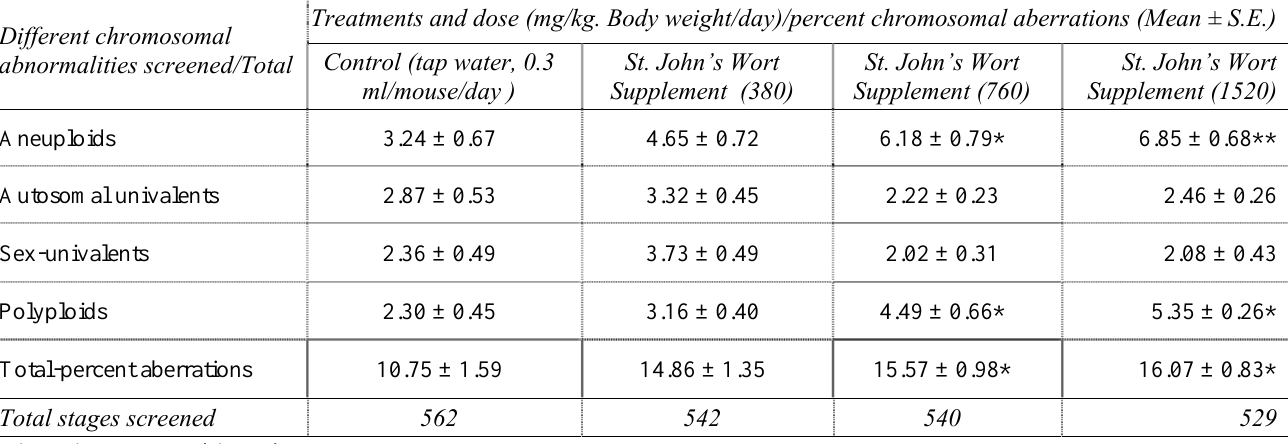
Table 2: Effect of St. John’s Wort Supplement on testis chromosomes in Swiss albino mice after sub-acute treatment Different